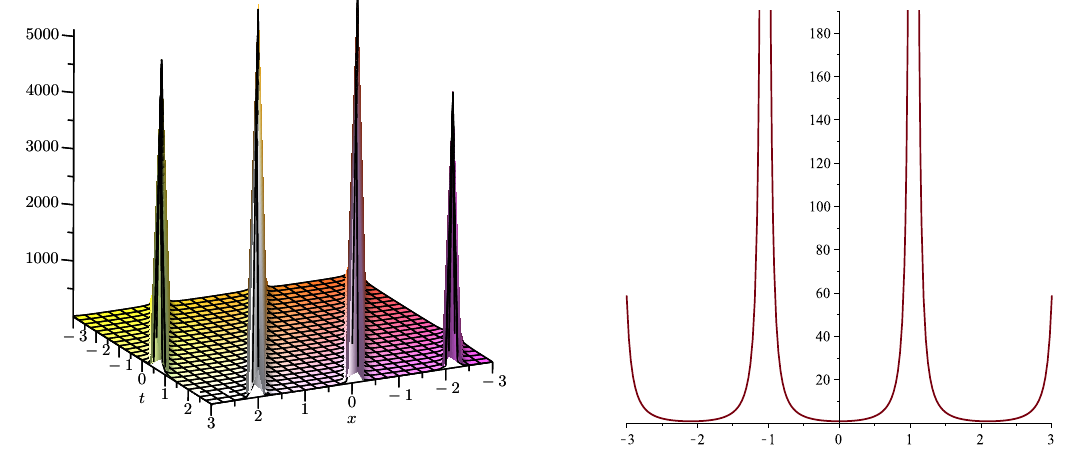
Figure 2. ( left ) 3D representation of solution (27) for ν = 1.5, κ = 1, ω = ξ 0 = 0.5 and periodic singular